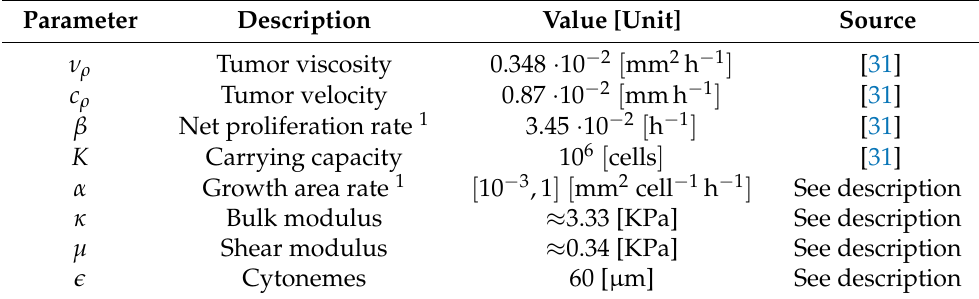
Table 1. Parameters used in